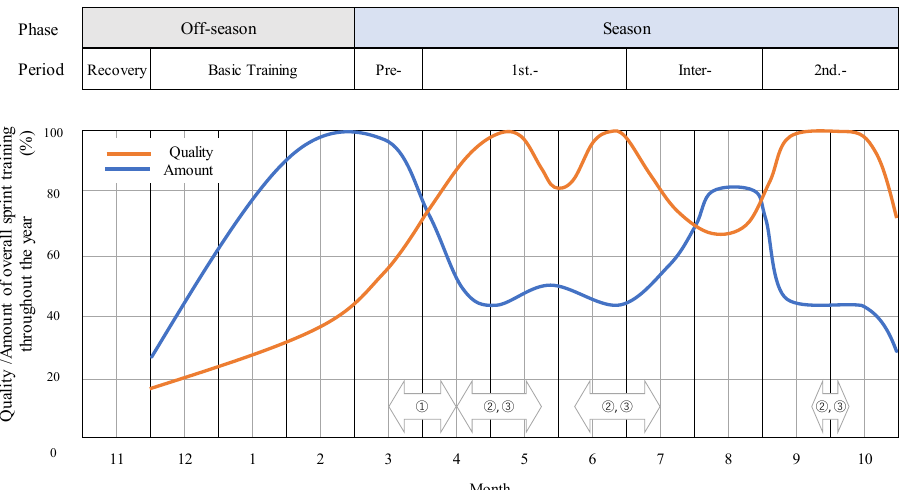
Figure 3. Prescription of standard program for tow-training. Feature: specific program (over-speed) for sprint training. Purpose: adapt the neuromuscular performance to high level/high stride frequency. Objectives: ① to increase maximal sprinting, ② to keep maximal sprinting, ③ to prepare for competition. Contents: ① ～ 105 ％ , 50 ～ 100 m × 3 ～ 5; ② 105 ～ 110 ％ , 50 m × 3; ③ 105 ～ 110 ％ , 50 m × 1;% represents the running velocity against maximal running. Distance and numbers are times of tow-training.